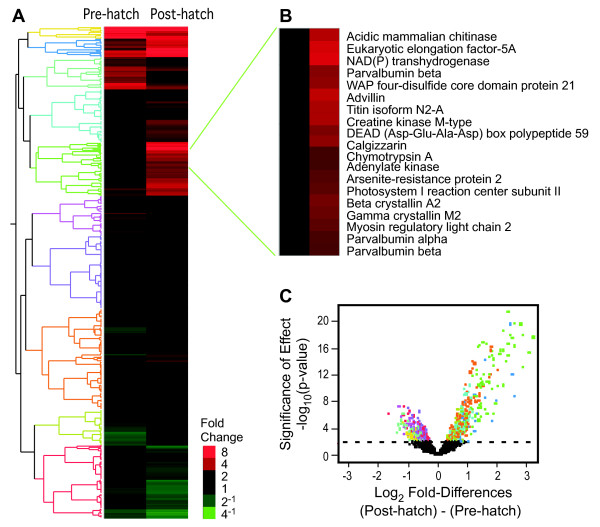
Gene expression pre and post-hatch. A. Hierarchical clustering of the 889 genes whose expression is significantly different (ANOVA, p < 0.01) between pre-hatch (stages 1-35) and post-hatch (stages 36-40) embryos. Red indicates high expression levels and green represents low expression levels. Clusters of genes with similar expression patterns are shown on the left (gene tree). The fold-change scale refers to differences in gene expression between pre- and post-hatch embryos. B. Enlargement of a subset of genes with high expression levels post-hatch. Thirteen unannotated genes are not included in the enlargement. C. Significance of pre and post-hatch expression levels. Significances of differences as - log10(p-values) are plotted against log2 differences in expression of pre and post-hatch embryos. The colors of the points correspond to the colors of the gene tree in 3A.